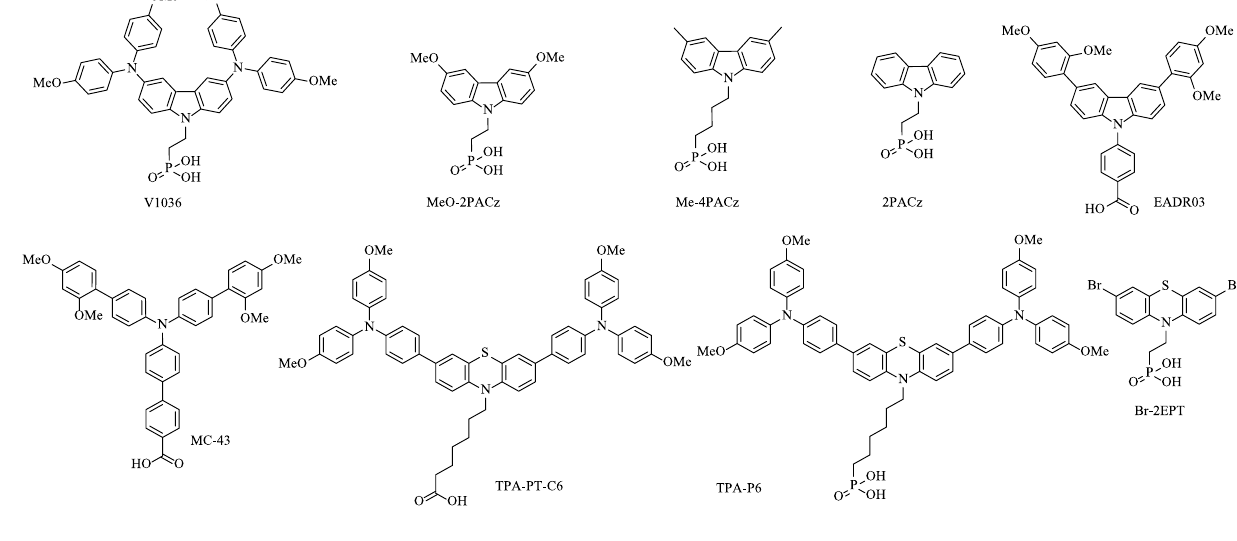
Fig. 6 Molecular structure of representative SAM-based HTMs